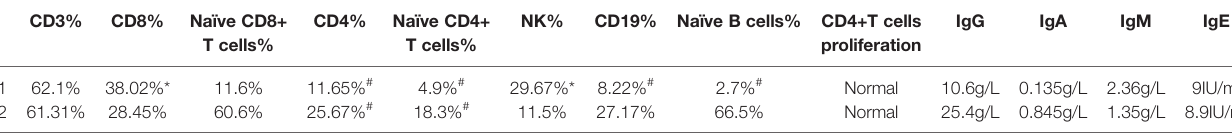
TABLE 2 | Immunologic features of lymphocytes and immunoglobulin in the patients.